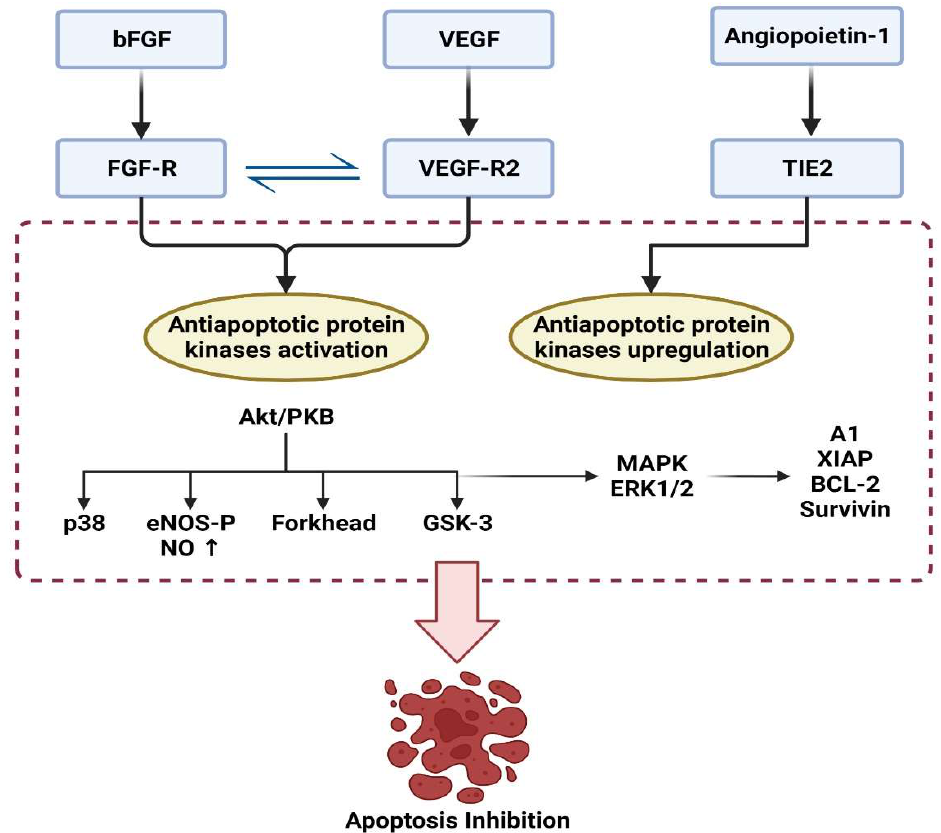
Figure 4. Regulation of apoptosis under the effect of angiogenic